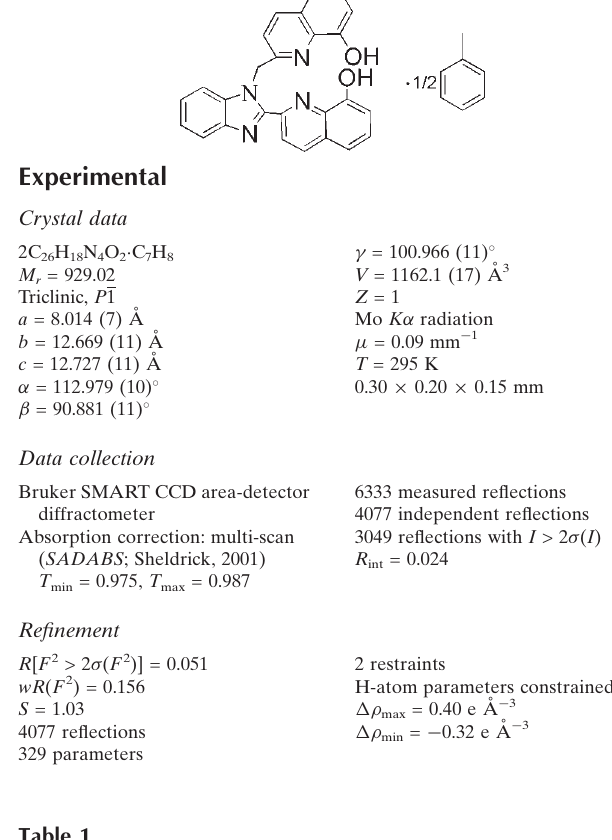
Hydrogen-bond geometry (A˚ , (cid:3) ). D —H (cid:2)(cid:2)(cid:2)